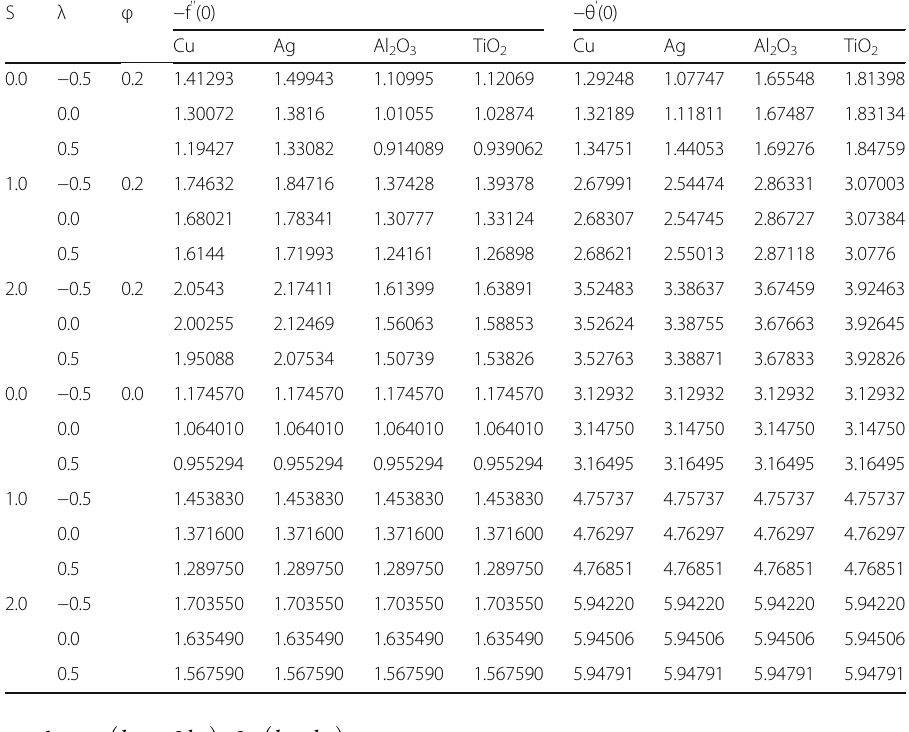
Table 5 Values of − f '' (0) and − θ ' (0) for various S , λ and φ with γ = π /3, Pr = 6.785, A = B = 0.5, M = f w =